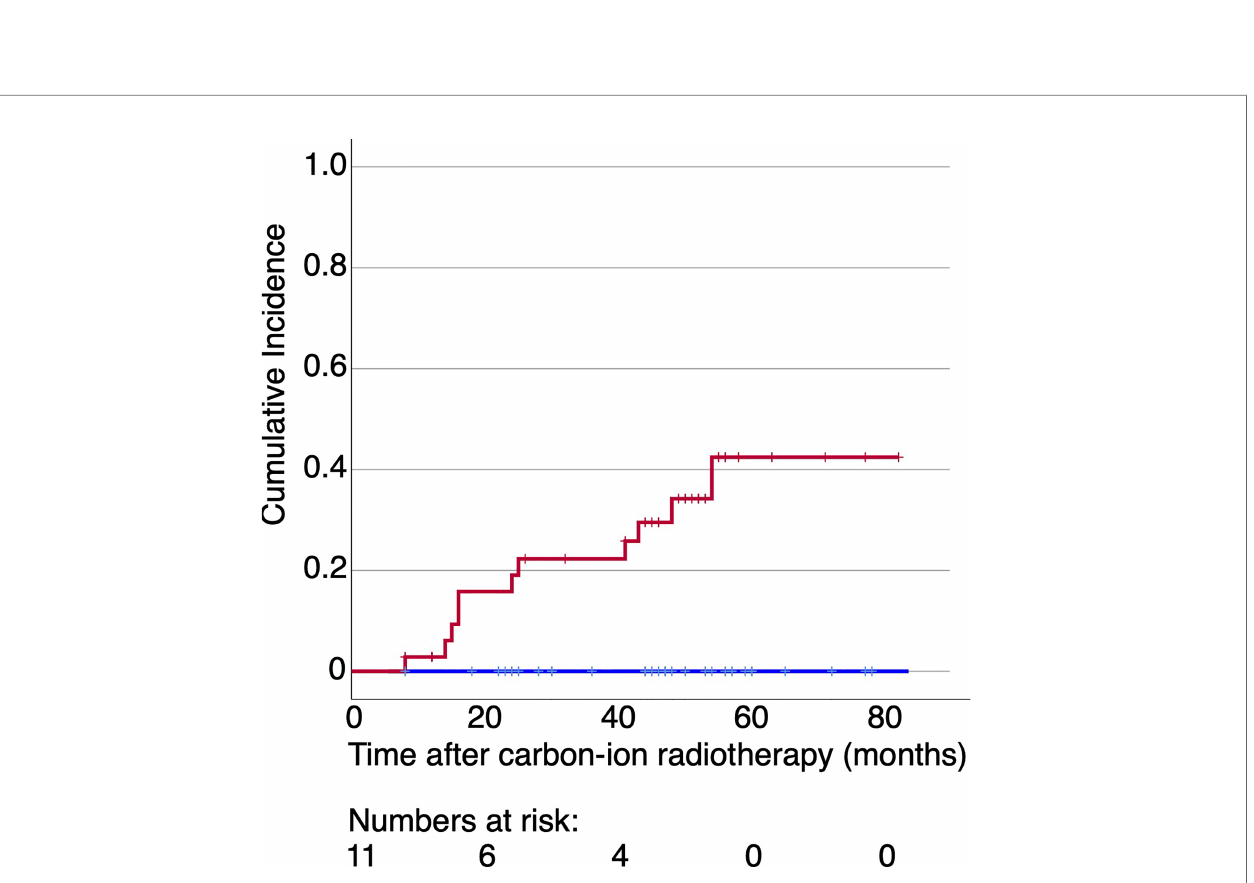
FIGURE 3 | Cumulative incidence of CIRT-related ORN over time for the patients irradiated with more than 60 Gy (RBE) at 0.6 ml of their maxilla (red line) or not (blue line) with data extracted form LEM-based treatment plans. No patients experienced ORN in case the dose to 0.6 ml of their maxilla was below 60 Gy